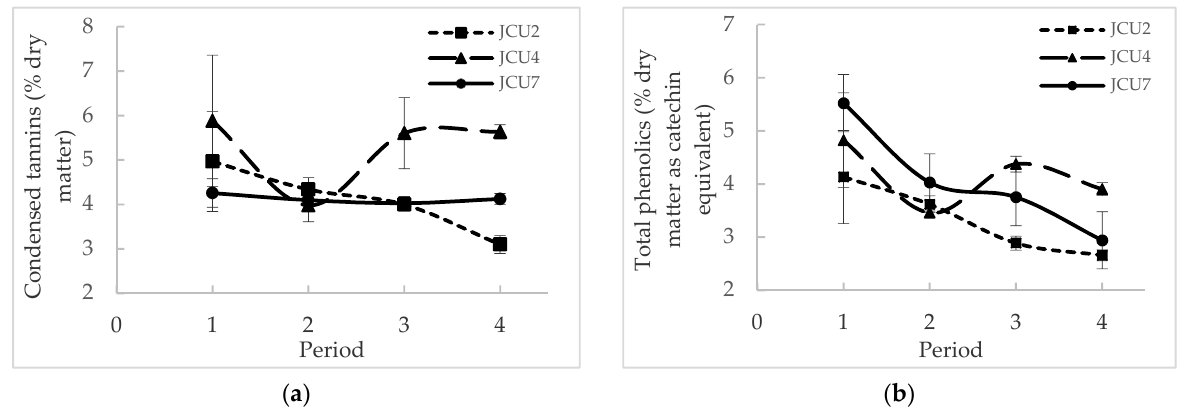
Figure 1. Variation in ( a ) condensed tannins (% dry matter) and ( b ) total phenolics (% dry matter as catechin equivalent) throughout the feeding period.